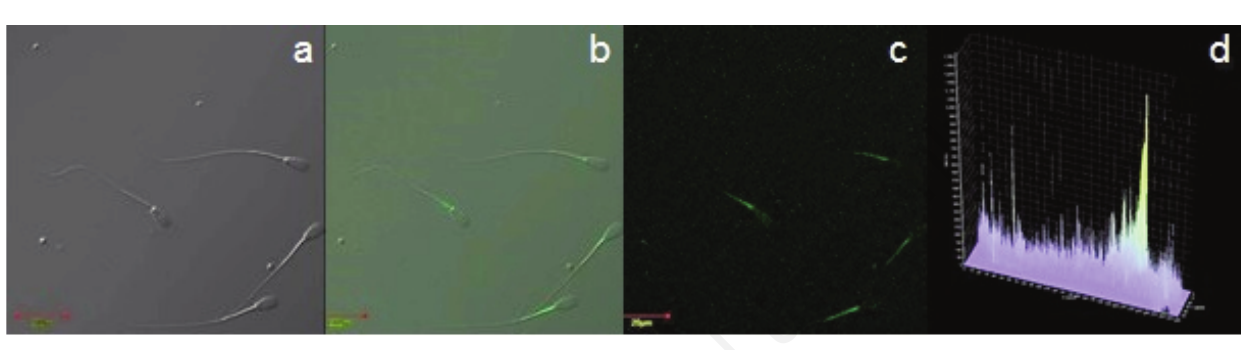
-tocopherol). a) Difference Inference α